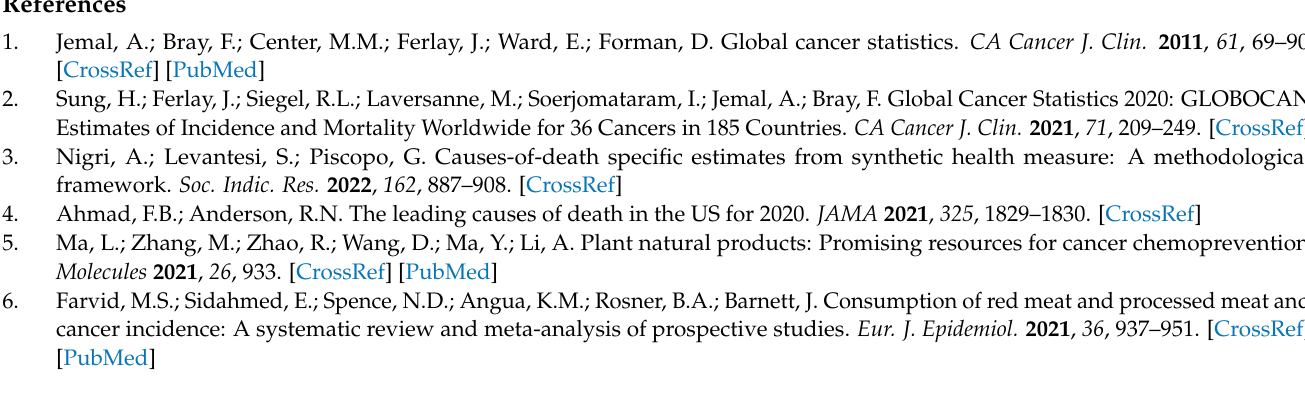
Figure S2: GC-MS mass spectra of BaP (A) and chrysene (C) recorded for the extract isolated from the pork meat roasted without additives (control sample). Spectra from the Mainlib and NIST databases are also shown for comparison: BaP (B) and chrysene